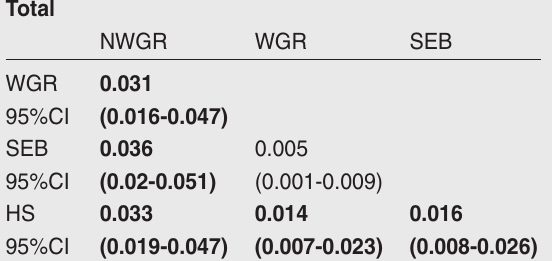
Table 3. Pairwise multilocus FST estimates describing the genetic divergence between the four stocks of Atlantic wal- rus based on 17 microsatellite loci (FSTAT, Goudet 1995). NWGR=Northwest Greenland, WGR=West Greenland, SEB=Southeast Baffin Island, HS=Hudson Strait. BOLD : significant after application of the sequential Bonferroni procedure (Rice